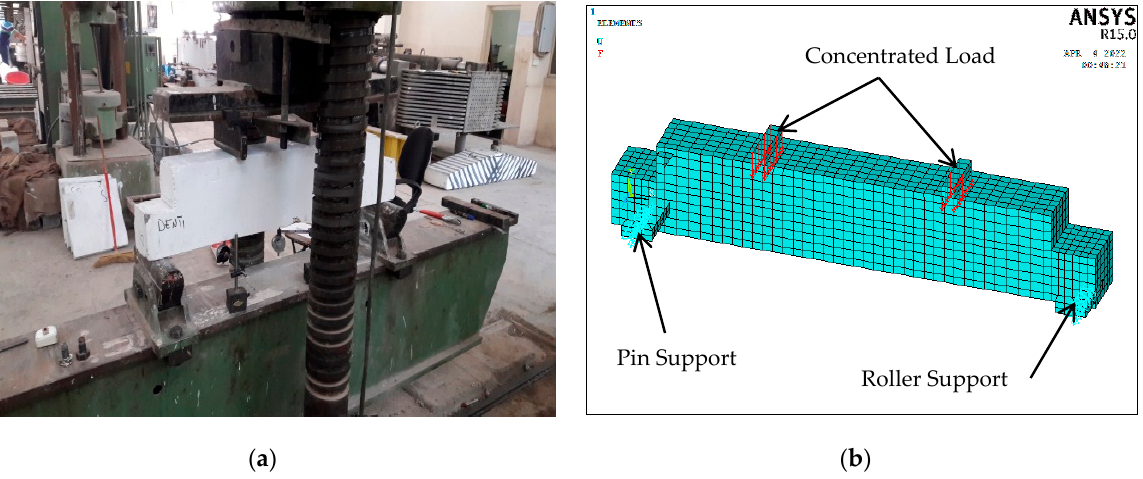
Figure 12. Typical modelling layout of the loads and supports for RC girder models with dapped ends. ( a ) Experimental setup [39]. ( b ) Numerical model.